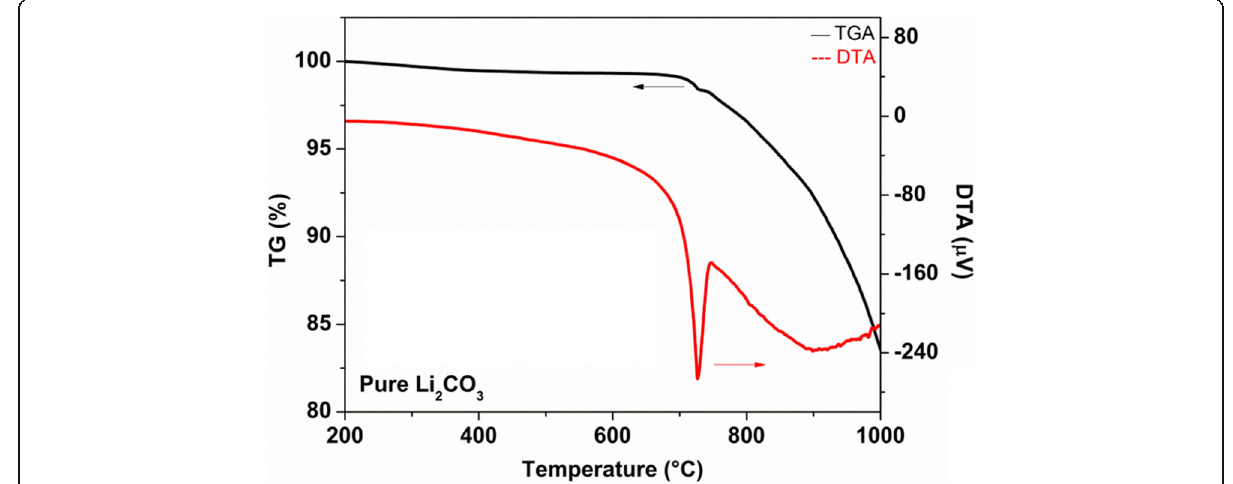
Fig. 2 TG-DTA curves of pure Li 2 CO 3 at 10